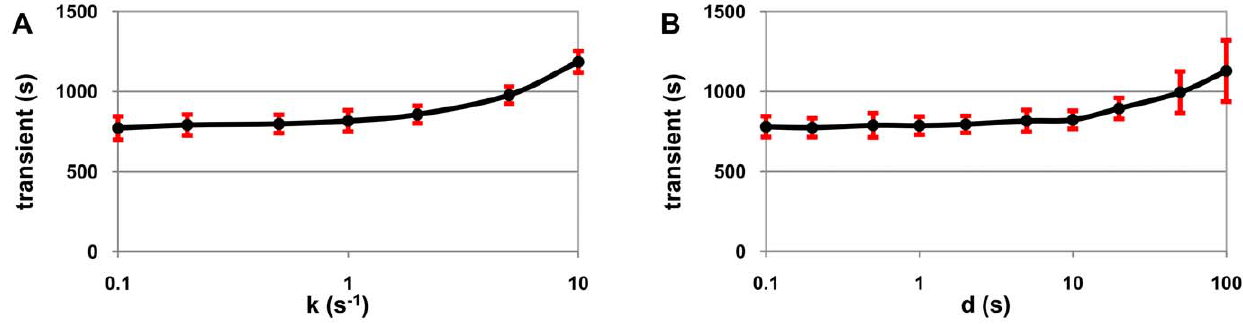
Figure 4. Pausing and the initial transient. Average initial transient with one standard deviation error bars (red bars) before reaching the homeostasis level of protein production as (A) pausing rate, and (B) pause duration vary (x-axis in log